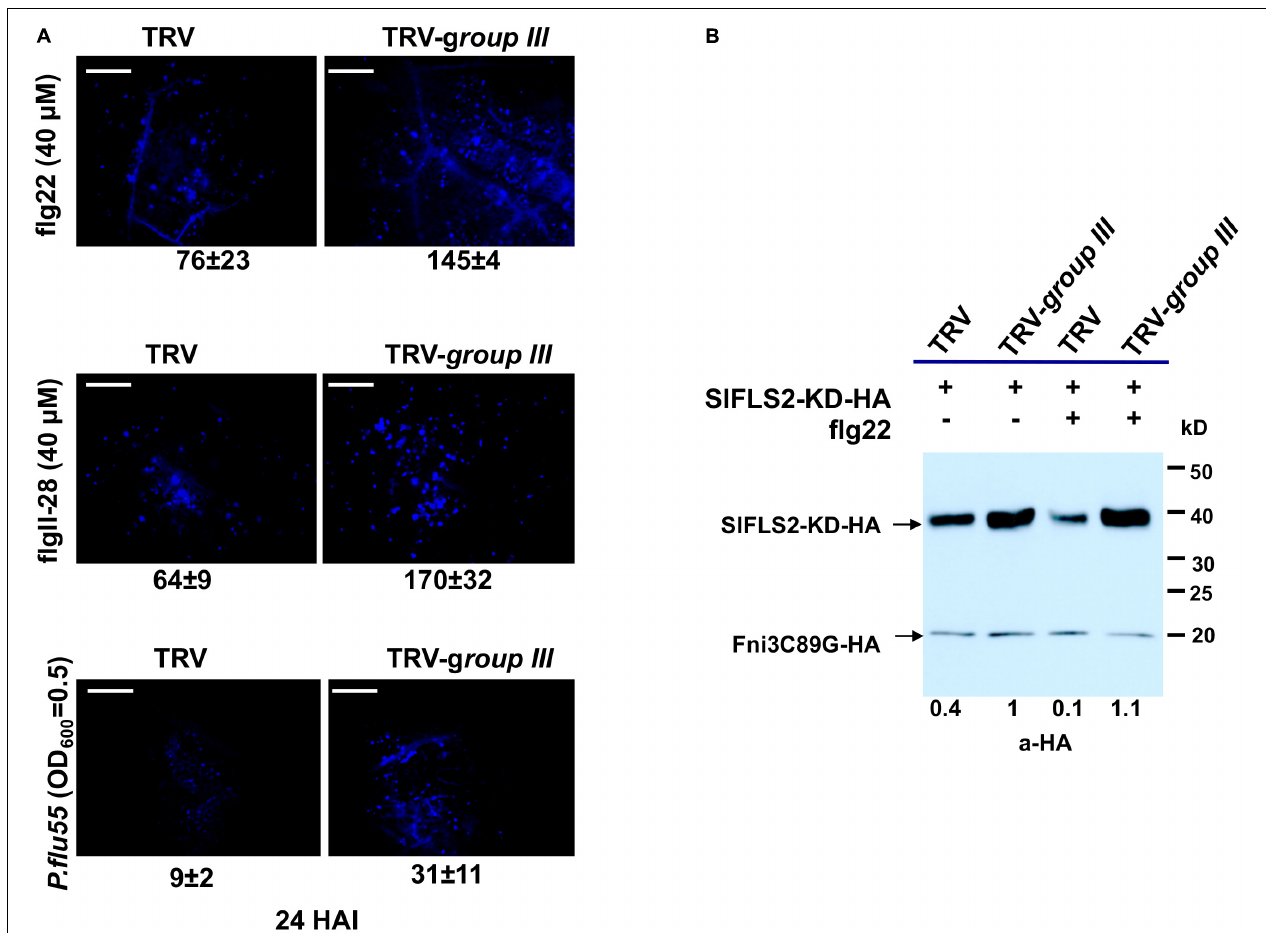
FIGURE 5 | The group III ubiquitin E2 enzymes are essential for PUB13 in attenuating flg22-triggered immune signaling. (A) Callose deposition in group III ubiquitin E2 genes-silenced (TRV- group III ) and non-silenced TRV control (TRV) N. benthamiana plants 24 h after infiltration with 40 µ M flg22, 40 µ M flgII-28, and 2.5 × 10 8 CFU/ml P. flu55, respectively. Representative microscopic views of callose formation at the infiltrated leaf area are shown. Numbers below each image represent the mean number of callose formation in at least 36 microscopic views ( n ≥ 36) from two biological replicates with standard deviation indicated. The experiment was repeated two times with similar results. (B) PUB13-promoted degradation of FLS2 kinase domain (FLS2-KD) in group III ubiquitin E2 genes-silenced (TRV- group III ) and non-silenced TRV control (TRV) N. benthamiana protoplasts. HA-fused FLS2-KD was expressed in protoplasts derived from corresponding plants with or without 1 µ M flg22 treatment. The accumulation of FLS2-KD was detected by immunoblot. The HA-fused Fni3C89G was used as internal control for equal transfection of the protoplasts. Numbers under the image denote the relative expression level of FLS2-KD in different lanes, with the expression in TRV -group III protoplasts without flg22 treatment set as 1. This experiment was repeated three times with similar